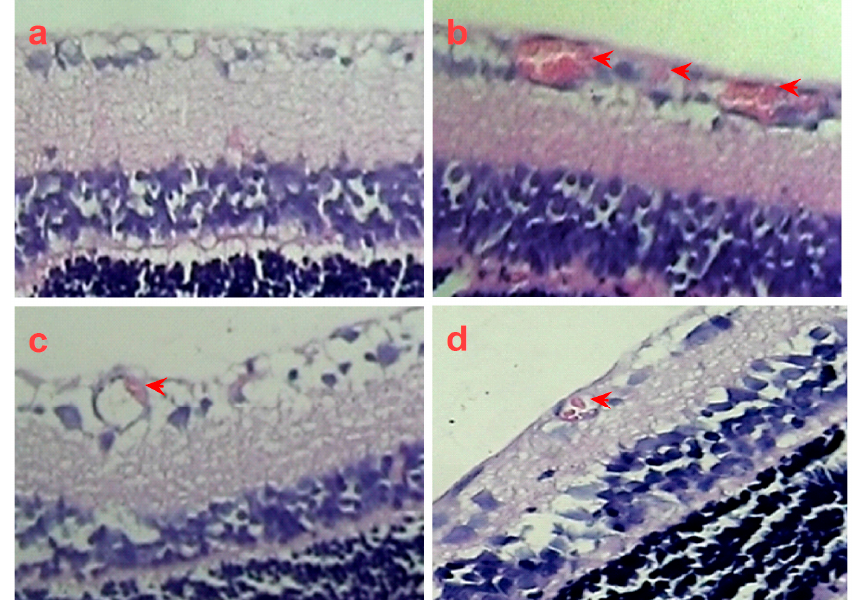
Figure 7. The in vivo effect of SPN on retinal neovascularization in H&E-stained retinal tissue sections (400 × ). Control group ( a ), rat pups fostered under normoxia condition; oxygen-induced retinopathy (OIR) rats were intraperitoneally administered with normal saline (negative control, b ), 1.0 mg/kg Conbercept (positive control, c ), or 10.0 mg/kg SPN ( d ). The arrows show neovascular nuclei or vessels. Ten rats were used for each group.